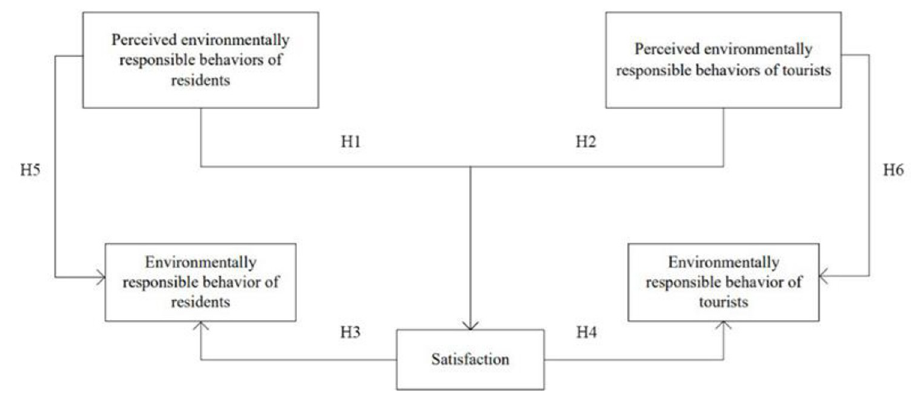
Fig 1. Research theoretical models.